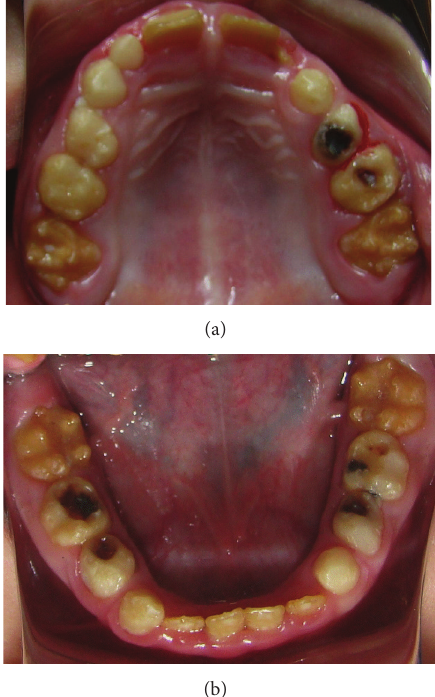
Figure 3: (a) Occlusal view of the maxillary; (b) occlusal view of the